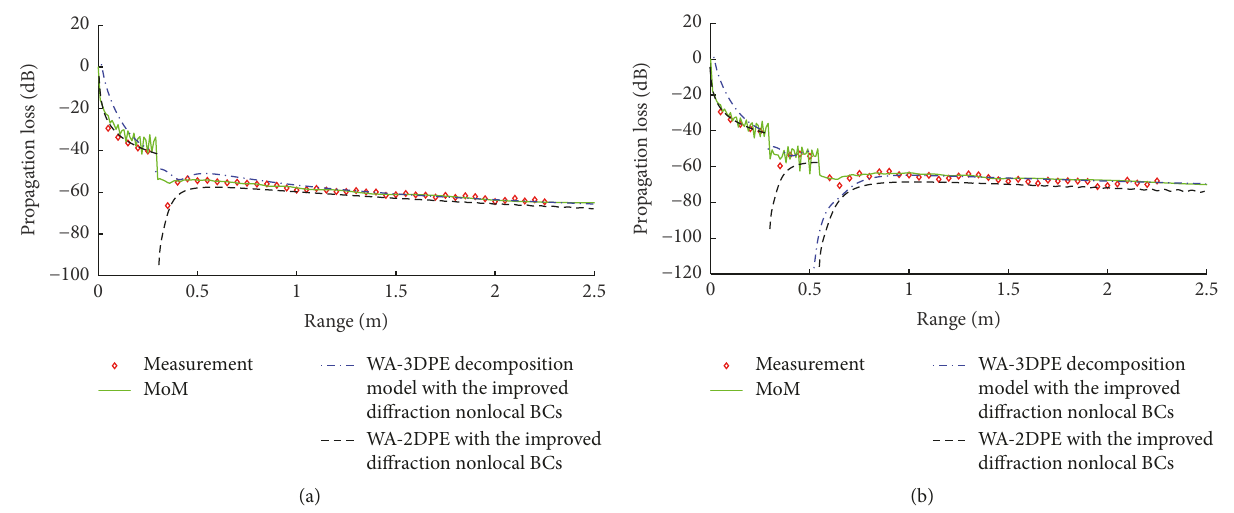
Figure 3: Comparison of the results of the WA-3DPE decomposition model with the improved diffraction nonlocal BCs with the measurement, MoM, and WA-2PDE results: (a) propagation loss versus range for single knife edge and (b) propagation loss versus range for double knife